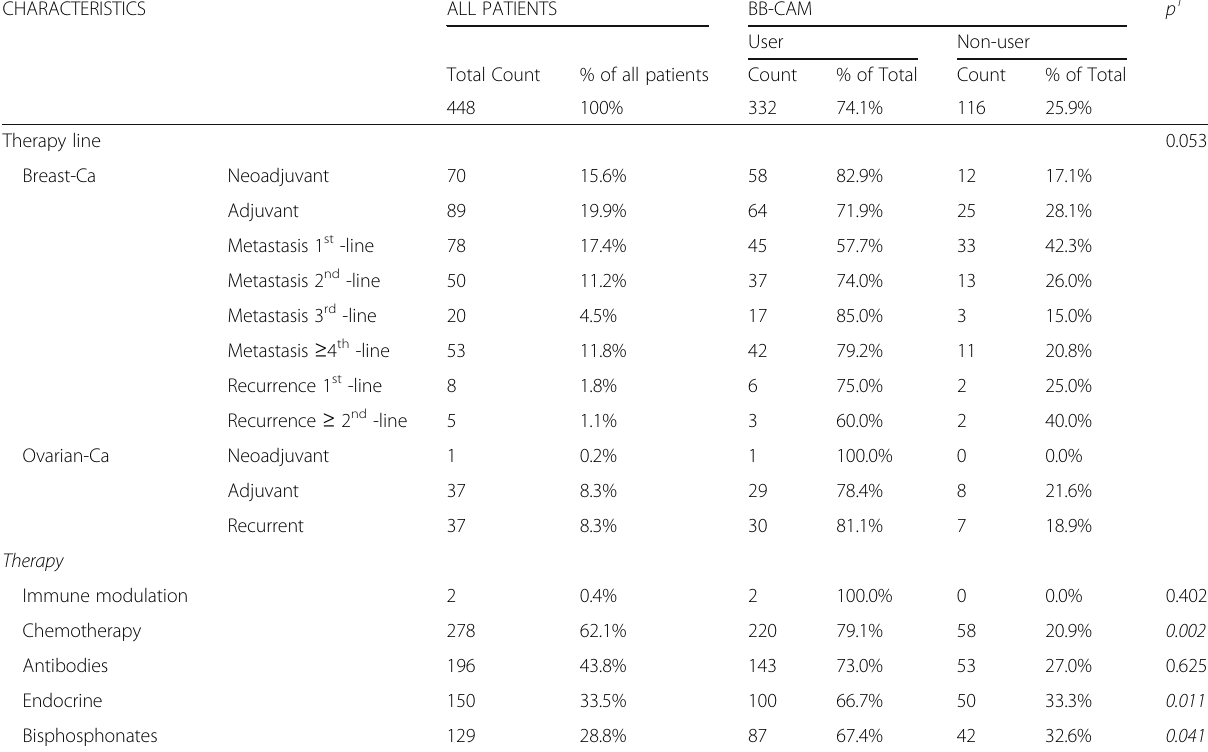
Table 2 Selected therapy characteristics of the total study cohort with univariable analyses of BB-CAM use CHARACTERISTICS ALL PATIENTS